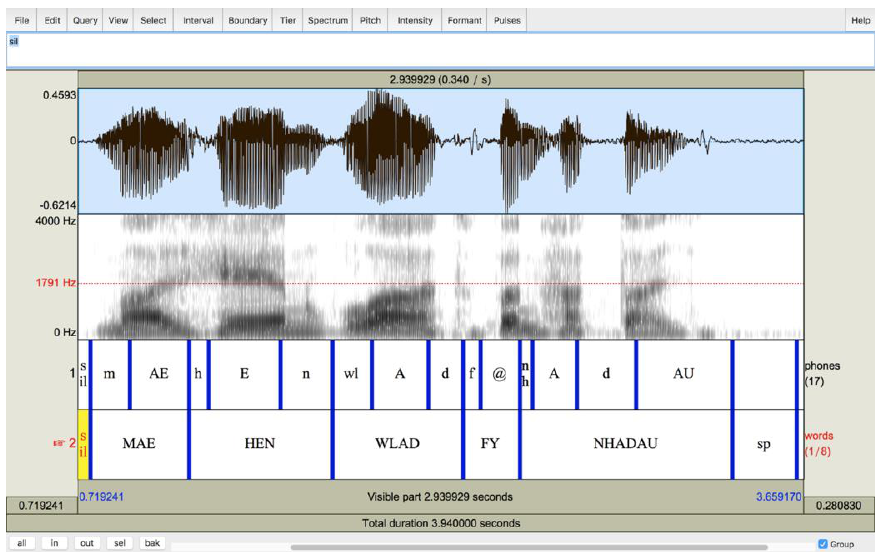
Figure 4. Praat output showing forced alignment for Mae hen wlad fy nhadau, the first line of the Welsh national anthem Land of my fathers .